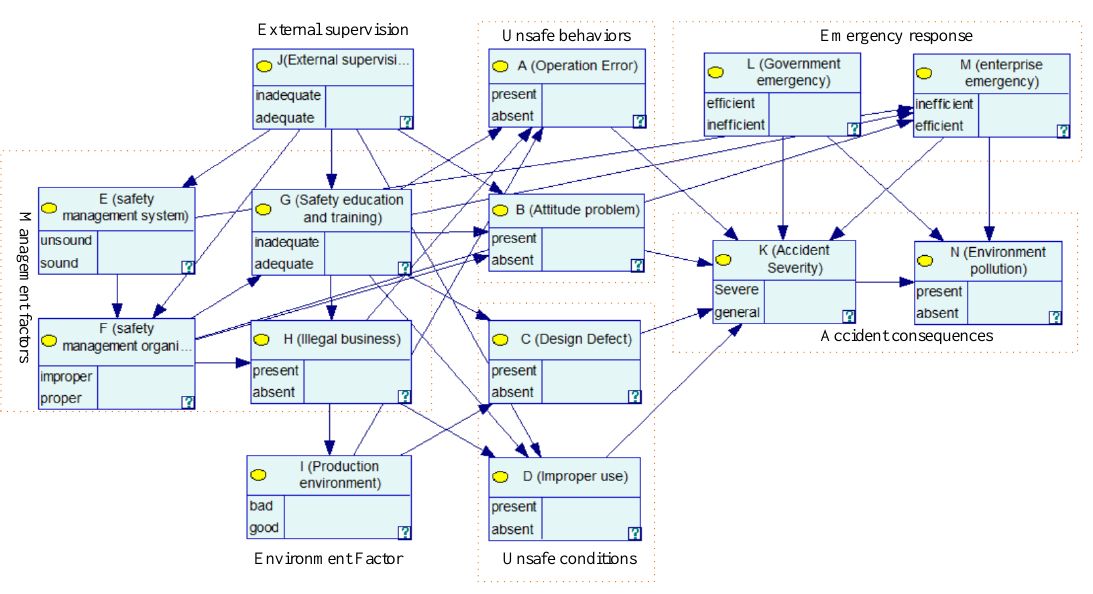
Figure 3. Initial Bayesian network (BN) structure for CPEAs.